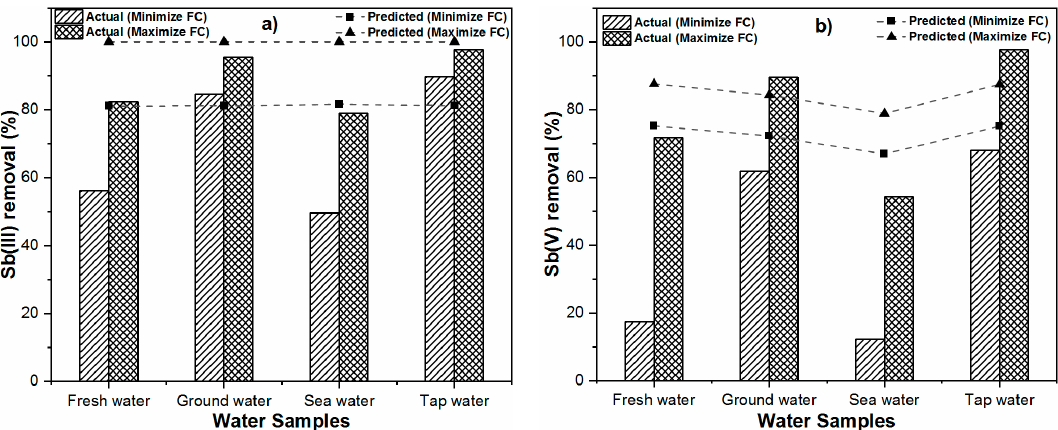
Figure 4. Actual and predicted removal efficiencies of ( a ) Sb(III) and; ( b ) Sb(V) for various environmental water samples using the Box–Behnken statistical experiment design (BBD) model with minimizing and maximizing FC dose as a considerable factor.